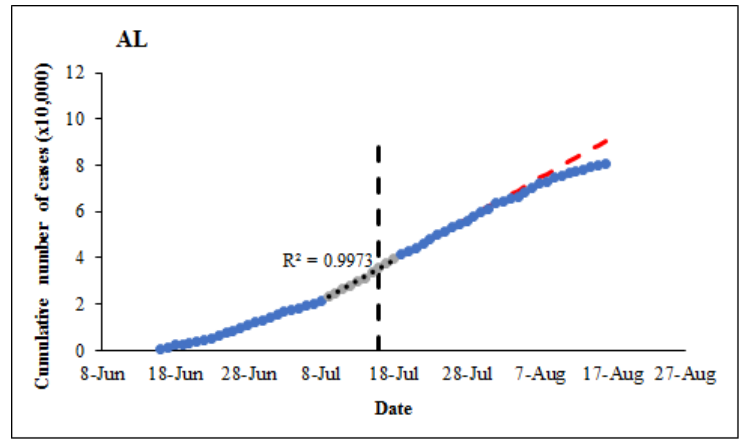
Figure 1. Cumulative number of COVID-19 cases in Alabama state between 16 June–19 August. Linear regression equation (R 2 = 0.9973) was used to estimate the number of cases prevented by 21 days (5804) and 28 days (10,763), after the face covering (FC) mandate. The slope (d −1 ) indicates daily rate of change in confirmed cases.